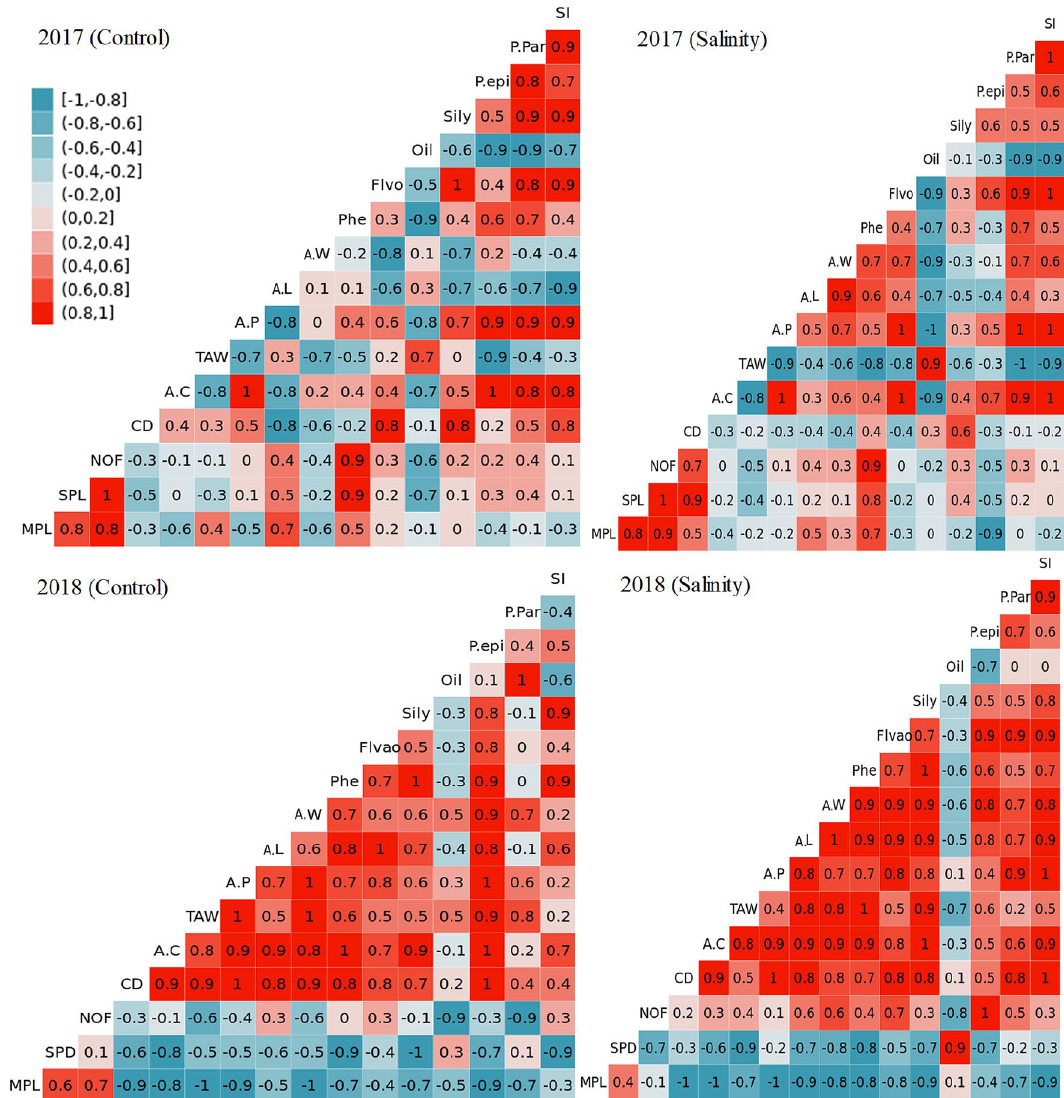
Figure 6. Pearson’s correlation matrix between different growth and yield parameters under control and salt stress conditions during 2017 and 2018. Correlation matrix of different dependent variables with independent variables (ecotypes) under control stress conditions during 2017. SI seed integument epidermis, P-Par pericarp parenchyma, P-epi pericarp epidermis, Sily silymarin, Flavo flavonoids, Phe Phenolics, AW achene width, AL achene length, A.P achene/plant, TAW thousand achene weight, A.C achene/capitulum, CD capitulum diameter, NOF number of flowers, SPL short peduncle length, MPL main panicle length. Blue box represents negative correlation, while red for positive